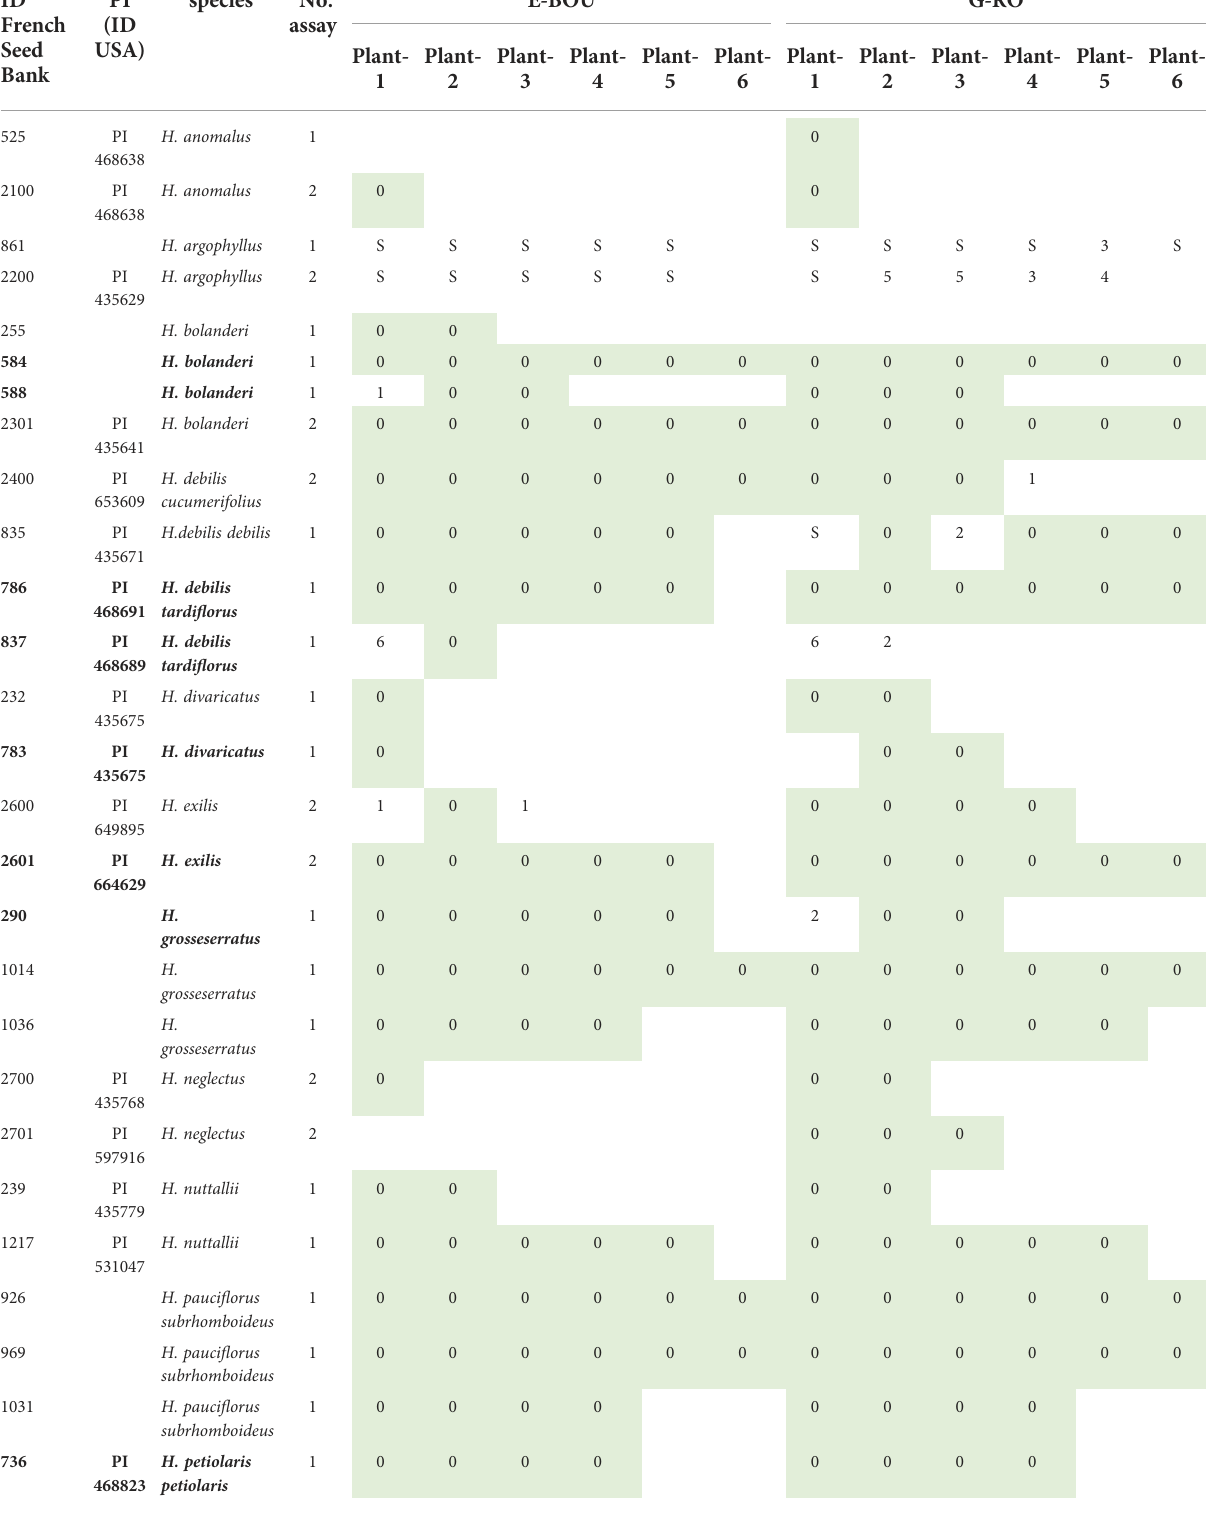
TABLE 2 Results for the phenotyping of wild Helianthus species (other than H. annuus ) in 6 L pots to O. cumana races E-BOU and